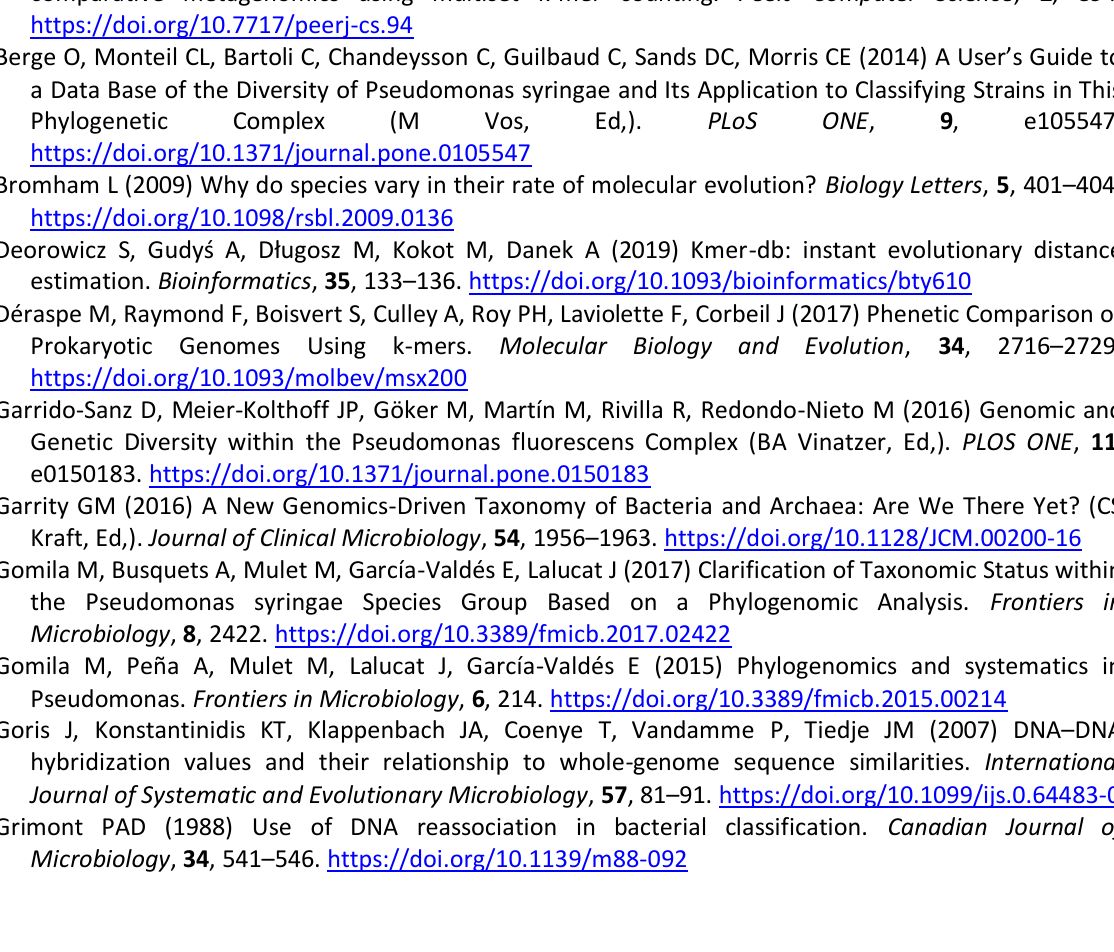
TableS1.csv : Pseudomonas groups. Description of the 350 groups obtained after clustering at 50% of shared 15-mers. For each group, the Pseudomonas group (Hesse et al. 2018) and subgroup (Berge et al. 2014; Gomila et al. 2017, 2015; Peix et al. 2018; Garrido-Sanz et al. 2016; Hesse et al. 2018) are displayed. FigureS1.html : Zoomable circle packing representation of Pseudomonas genome sequences. Similarities between genome sequences were assessed by comparing the percentage of shared 15-mers. Each dot represents a genome sequence, which is colored according to its group of species (Berge et al. 2014; Gomila et al. 2017, 2015; Peix et al. 2018; Garrido-Sanz et al. 2016; Hesse et al. 2018). These genome sequences have been grouped at three distinct thresholds for assessing infraspecific (0.75), species-specific (0.5) and interspecies relationships (0.25).